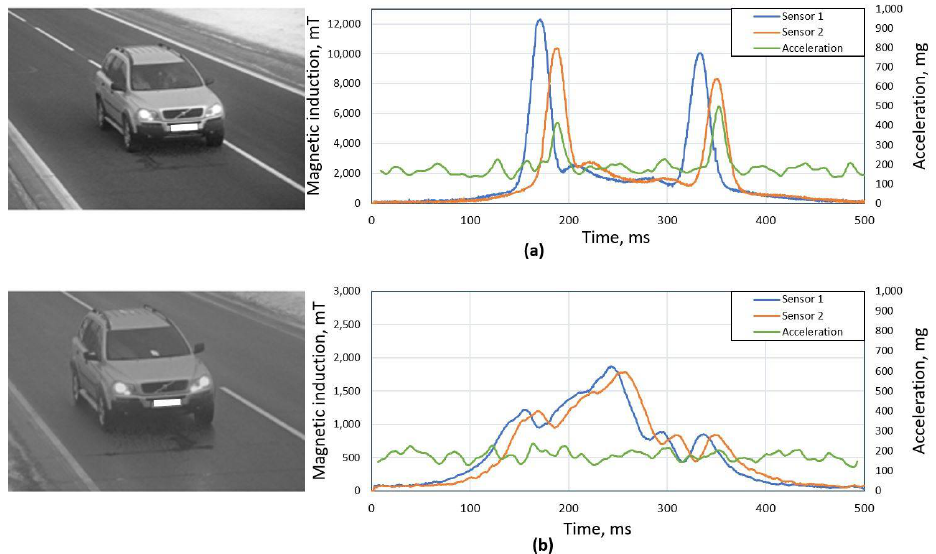
Figure 1. An example of same vehicle passing traffic monitoring station in two ways: ( a ) right side wheels are directly passing over the sensor, ( b ) vehicle driving at the center of sensor hub. In the plots next to the images, temporal data of magnetic signature of two magnetic sensors and accelerometer signal are shown.